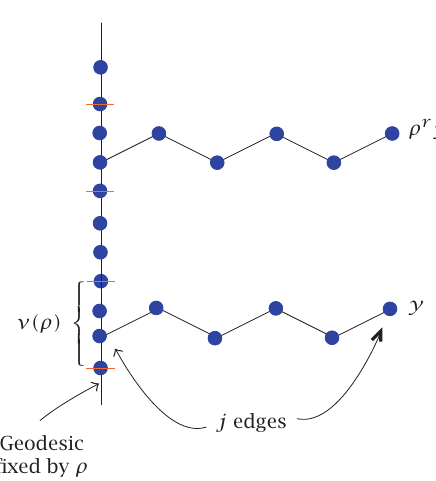
Figure 4.1 . Finding the fundamental domain Γ ρ \ Ξ when ν(ρ) = 3, r = 2, j =